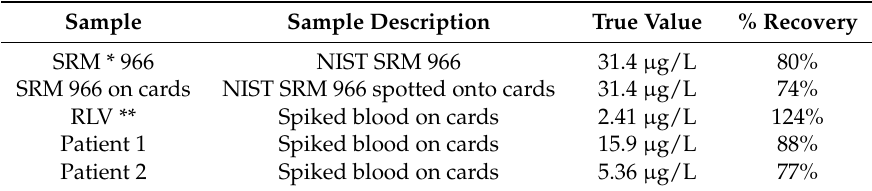
Table 1. Performance of dried bloodspot quality control